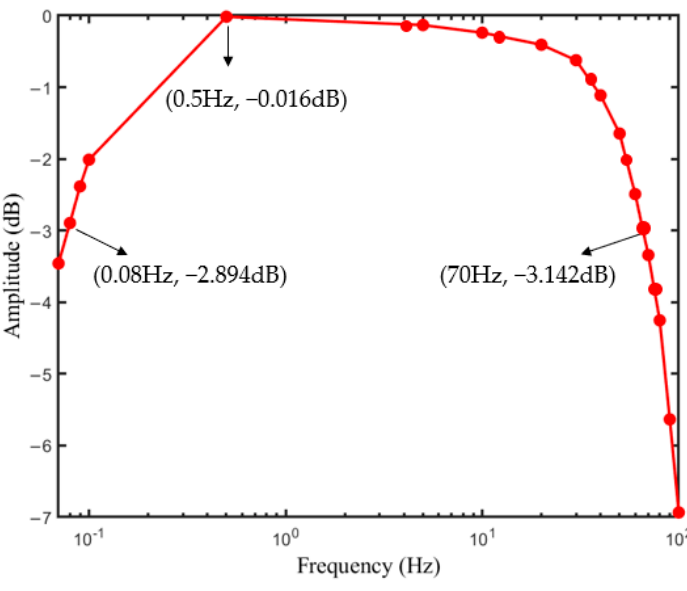
Figure 6. Frequency response measurement result.